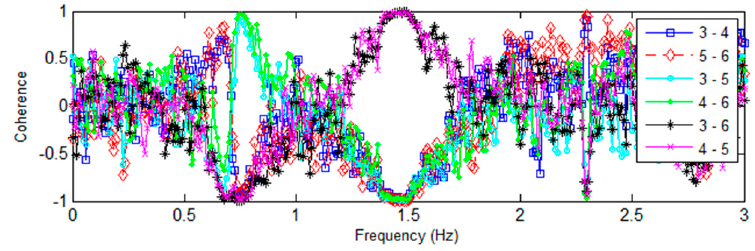
Figure 15. Coherence between vertically-aligned accelerometers in the basement of the Green Building subjected to the 4th of July fireworks show.